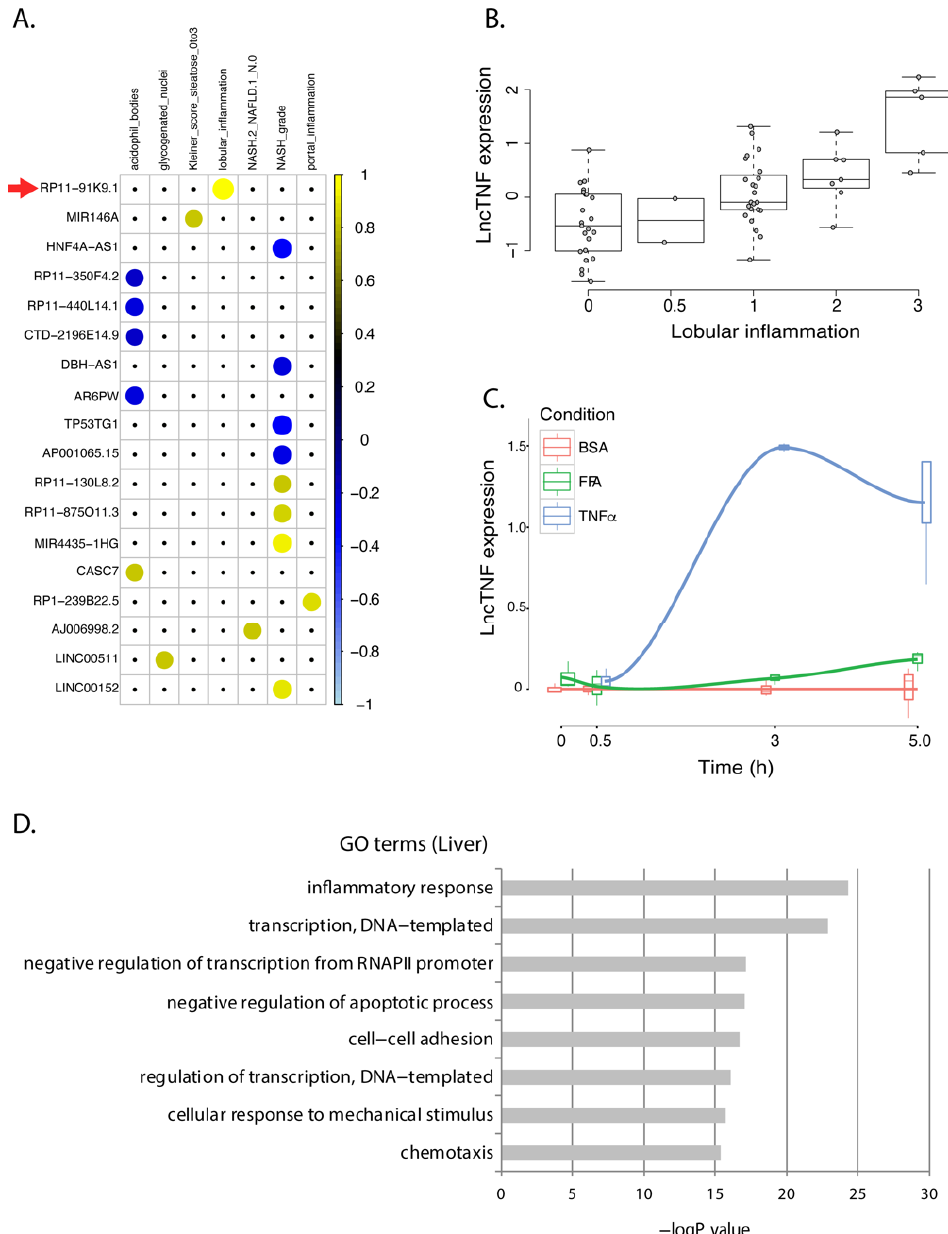
Figure 3. lncTNF expression in FFA- and TNF α -exposed HepG2 cells and correlation with NASH phenotypes in human livers. ( A ) Correlation plot representing the correlation coefficients (Spearman) between 18 NASH-associated lncRNAs that showed the same direction of dysregulation in the HepG2 model of NASH. Positive correlations are shown in yellow. Negative correlations are shown in blue. LncTNF, corresponding to RP11-91KP.1, is marked with a red arrow. Rows represent genes and columns represent NASH phenotypes. ( B ) Correlation between normalized lncTNF expression ( y -axis) and NASH grade ( x -axis) in human liver samples. ( C ) Normalized lncTNF expression ( y -axis) in HepG2 cells upon exposure to free fatty acids (FFA, green line), tumor necrosis factor alpha (TNF α , blue line), or control conditions (BSA: bovine serum albumin, red line). Mean values for three replicates are shown. x -axis represents exposure time in hours. ( D ) Gene ontology (GO) terms ( y -axis) and FDR corrected p -value ( x -axis) as defined by DAVID. Genes co-expressed with lncTNF from the human liver data (FDR < 0.05) were used as input for this analysis.